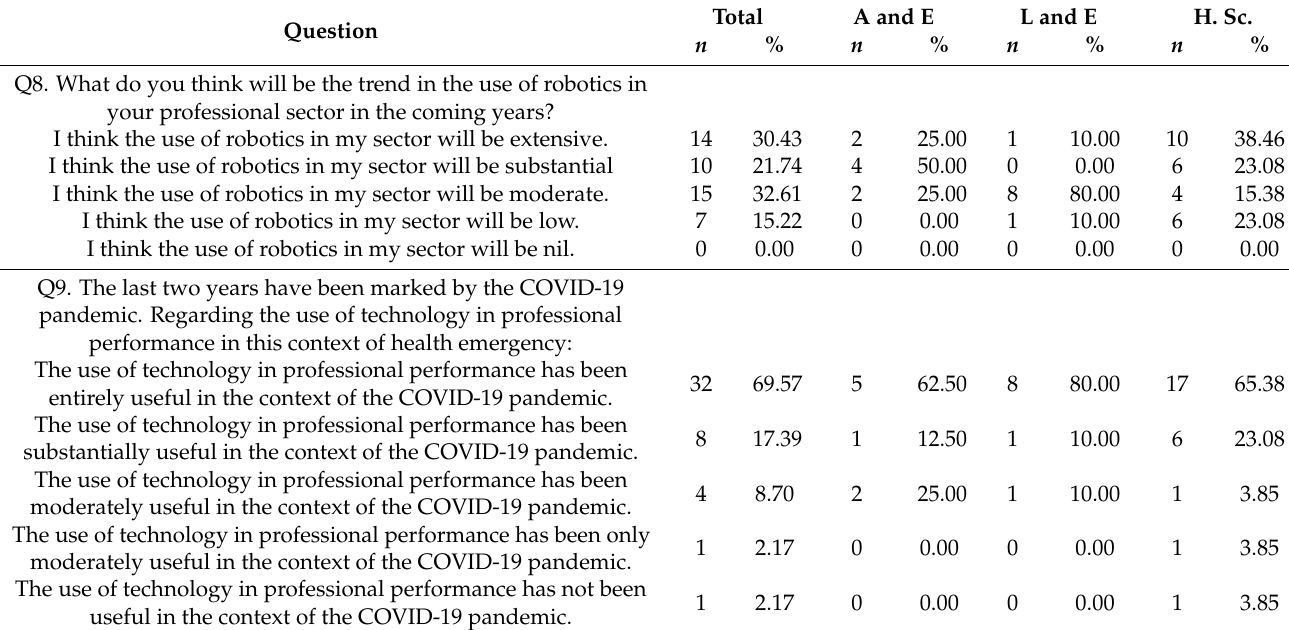
Table 7. Distribution of responses on the usefulness of technology and